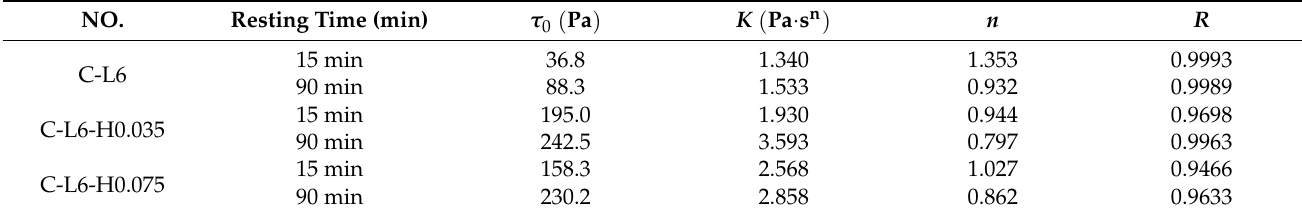
Table 10. Rheological parameters of C-L6-HPMC